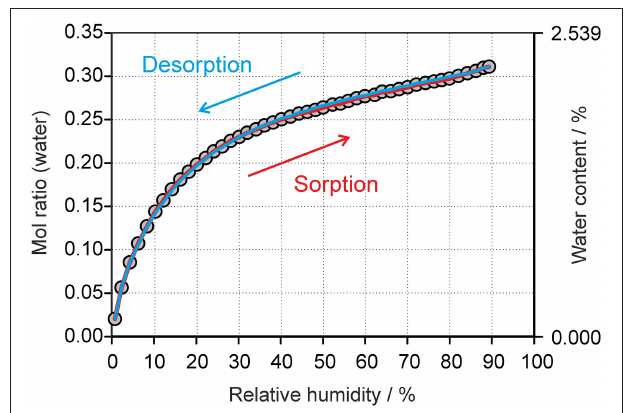
FIGURE 7 | Gravimetric moisture sorption/desorption isotherms of DDS 0.33-Hy at 25 ◦ C. Circles represent data points recorded at equilibrium conditions (see experimental